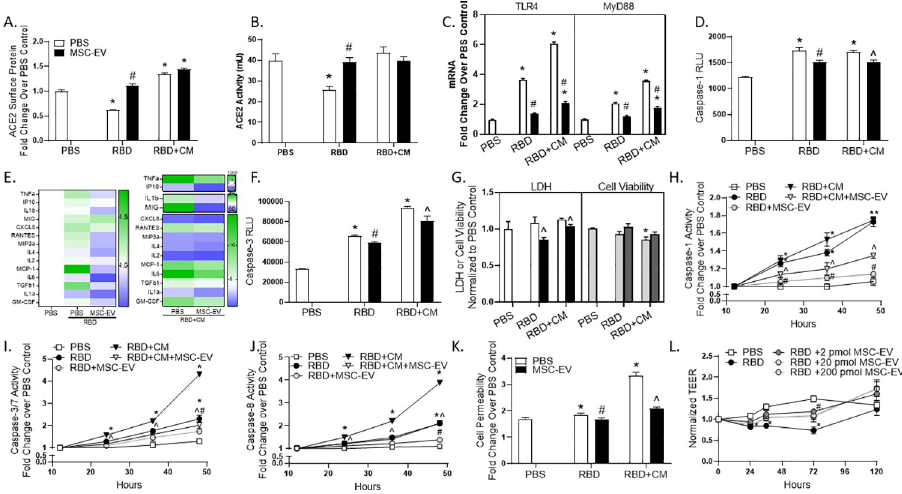
Fig 3. MSC-EVs improve ACE2 surface protein expression and cell health after SARS-CoV-2 exposure. Calu-3 cells were incubated with SARS-CoV-2 receptor binding domain (RBD) alone or in combination with tri-cytokine mix (CM). ACE2 surface protein (A) and activity (B), TLR4 and MyD88 gene expression (C), and caspase-1 activity (D) were evaluated in cells and cell lysates at 24 hours. Secreted cytokines (E) and cell lysate caspase-3 (F), LDH and cell viability (G) were evaluated at 24 hours. Activities of caspase-1, caspase-3/7, caspase-8 were evaluated in Calu-3 cell lysates over time (H), (I), (J). Cell permeability in Calu-3 lysates (K). Transepithelial/endothelial electrical resistance (TEER) was evaluated on primary human alveolar type 2 (AT2) and AT2 in co-culture with microvascular endothelial cells (MVEC; L). Error bars are SEM of the mean. � p � 0.05 vs unstressed; #p � 0.05 vs RBD; ^p � 0.05 vs RBD+CM.